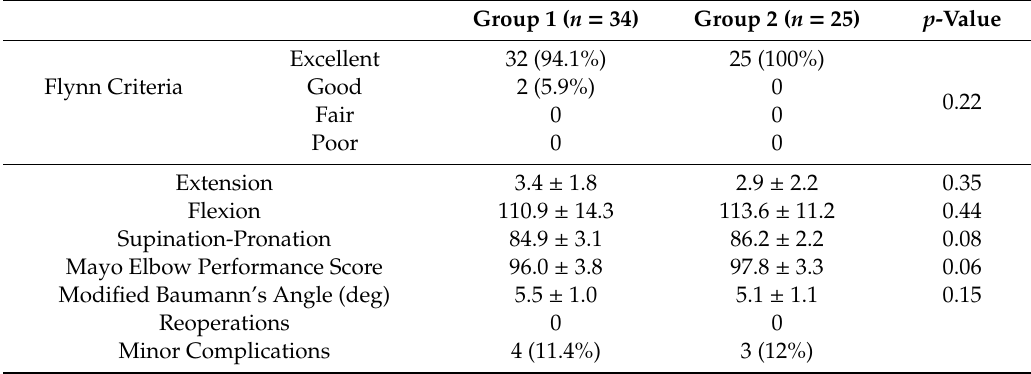
Table 4. Clinical and Radiological assessment